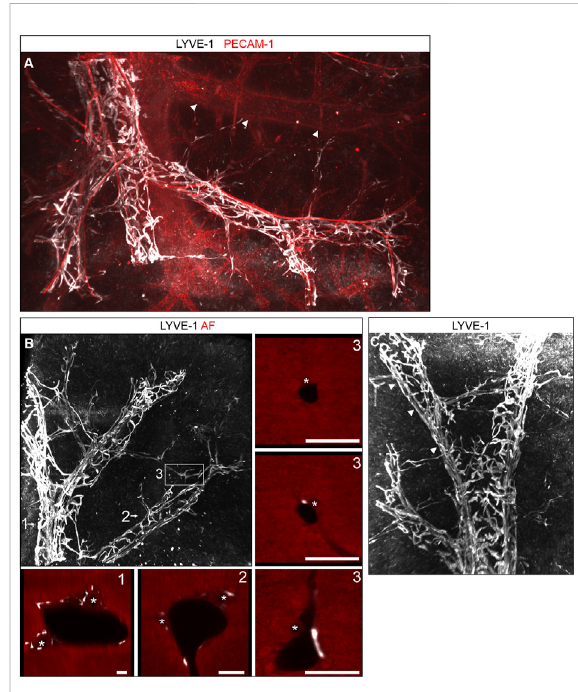
FIGURE 3 3D morphology of hepatic lymphatic vessels. ( A) : Digital 3D reconstruction of hepatic lobes whole mount immunostained for LYVE-1 and PECAM-1. The portal vein branches were covered by a dense network of lymph vessels. A central vein in the background(arrowheads) lacked lymphatic vessels. The lymphatic network consisted of spiky initials enwrapping the portal vein perpendicular to its orientation and of straight vessels running alongside the portal arteries (intense PECAM-1 staining). (B,C) Digital 3D reconstruction of liver specimens whole mount immunostained for LYVE-1, revealed a dense lymphatic network. Note the straight LYVE-1 positive vessels (arrowheads). ( B) (numbers side panels): Single optical sectional planes from the regions indicated by the numbers in the central panel. Besides LYVE-1 the auto fl uorescence (AF) signal at 546 nm (red) is shown for anatomical orientation. Lymphatics surrounded portal vein branchesandbileducts(asterisks)inlargerportaltracts(1,2).Initial bileductswerenotyetassociatedwithlymphvessels,howeverthe smallest lymphatic vessels appeared next to small bile ducts. At portal vein branch points this connection was transiently lost (3). Scale bar = 100